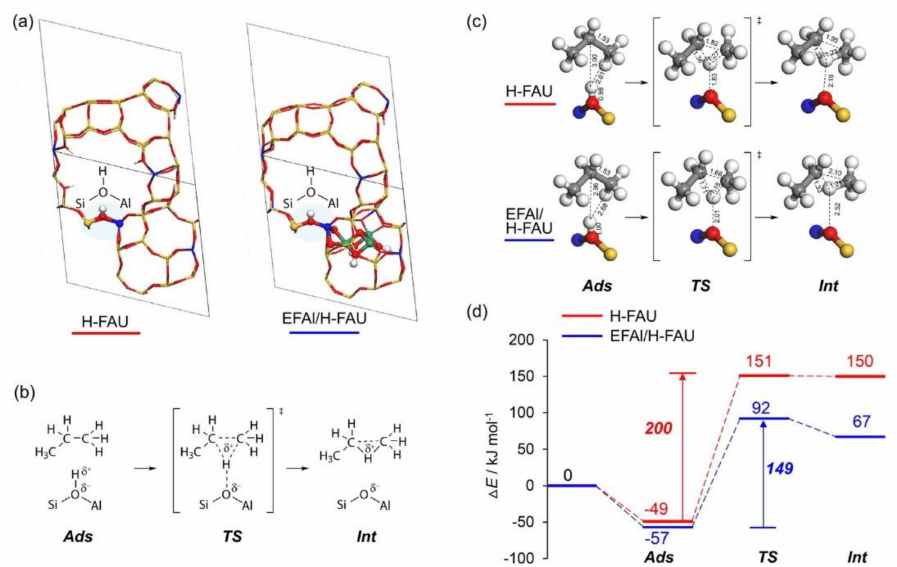
Figure 4. ( a ) The models of H-FAU (left) and EFAL/H-FAU (right). ( b ) The reaction mechanism of monomolecular propane cracking to form a carbonium ion intermediate via protonation of C–C bond. ( c ) The structures of reactants, transition states, and intermediates for propane cracking over H-FAU and EFAL/H-FAU. ( d ) The energy diagrams of propane cracking reactions over H-FAU and EFAL/H-FAU. Reprinted with permission from [37]. Copyright 2015, American Chemical